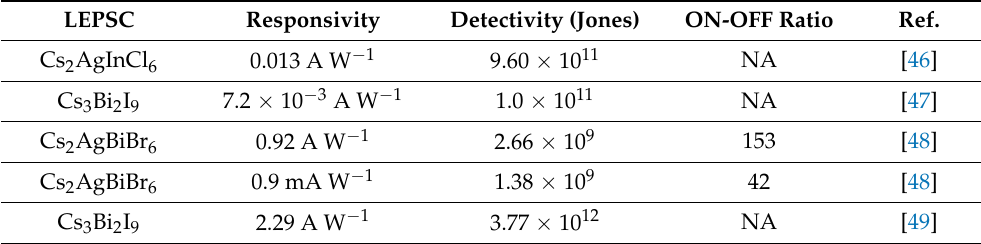
Table 2. Photodetection parameters of LFPSCs based devices.